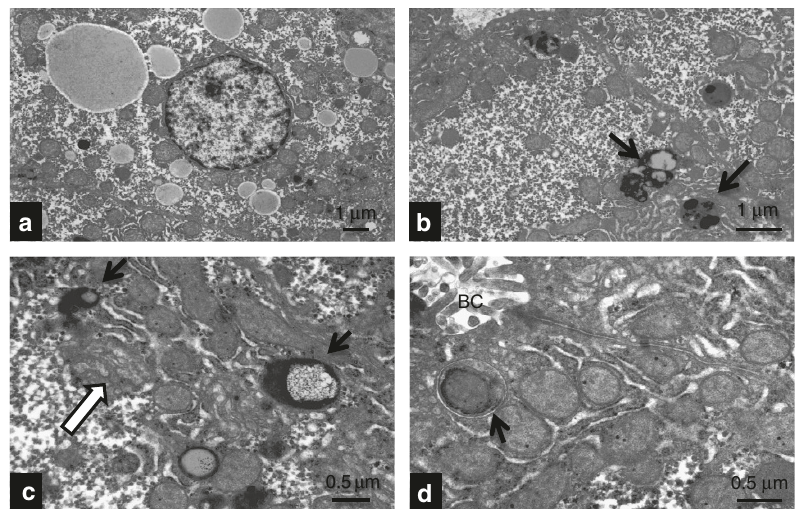
Figure 2 | Ultrastructural studies of a liver biopsy of patient 3.1. ( a ) A hepatocyte is surrounded by fat globules of variable size having the typical aspect of triglycerides, (cid:3) 4,000. ( b ) Hepatocyte showing relative translucency due to proliferated SER. Arrows point to lipofuscin bodies (lysosomes), (cid:3) 6,000. ( c ) Higher magnification showing an atypical lipofuscin body with a central reticulate content (black arrow). White arrow: section through a Golgi apparatus, (cid:3) 10,000. ( d ) A mitochondrion is engulfed in an autophagosome (arrow). BC, Bile canaliculus, (cid:3)